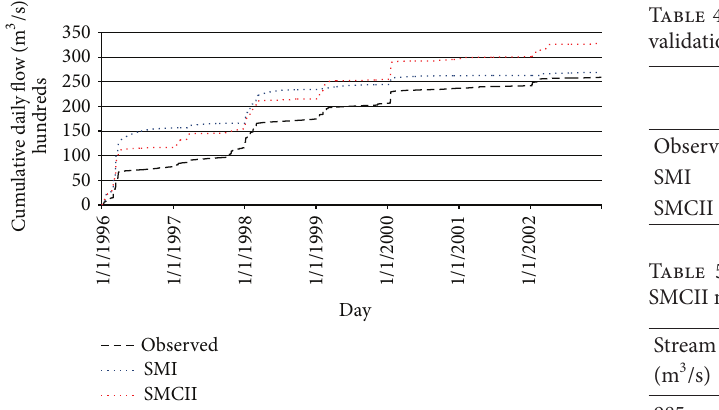
Figure 4: Predicted cumulative daily discharge by SMI and SMCII methods against observed cumulative daily discharge during cali- bration.